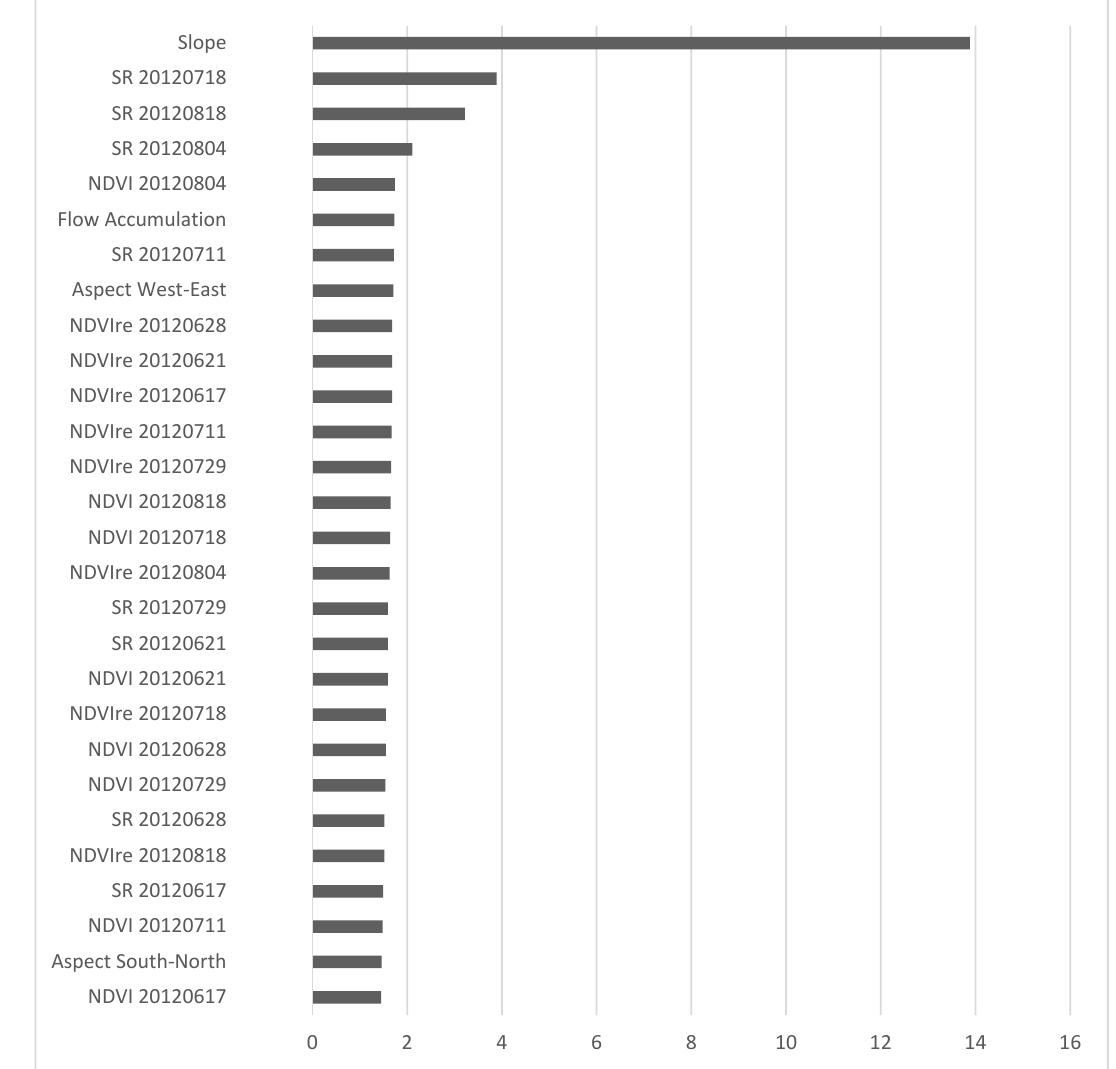
Figure A7. Importance of variables for the corn 2012 ANN model, as measured by Garson values (larger values indicate higher importance).